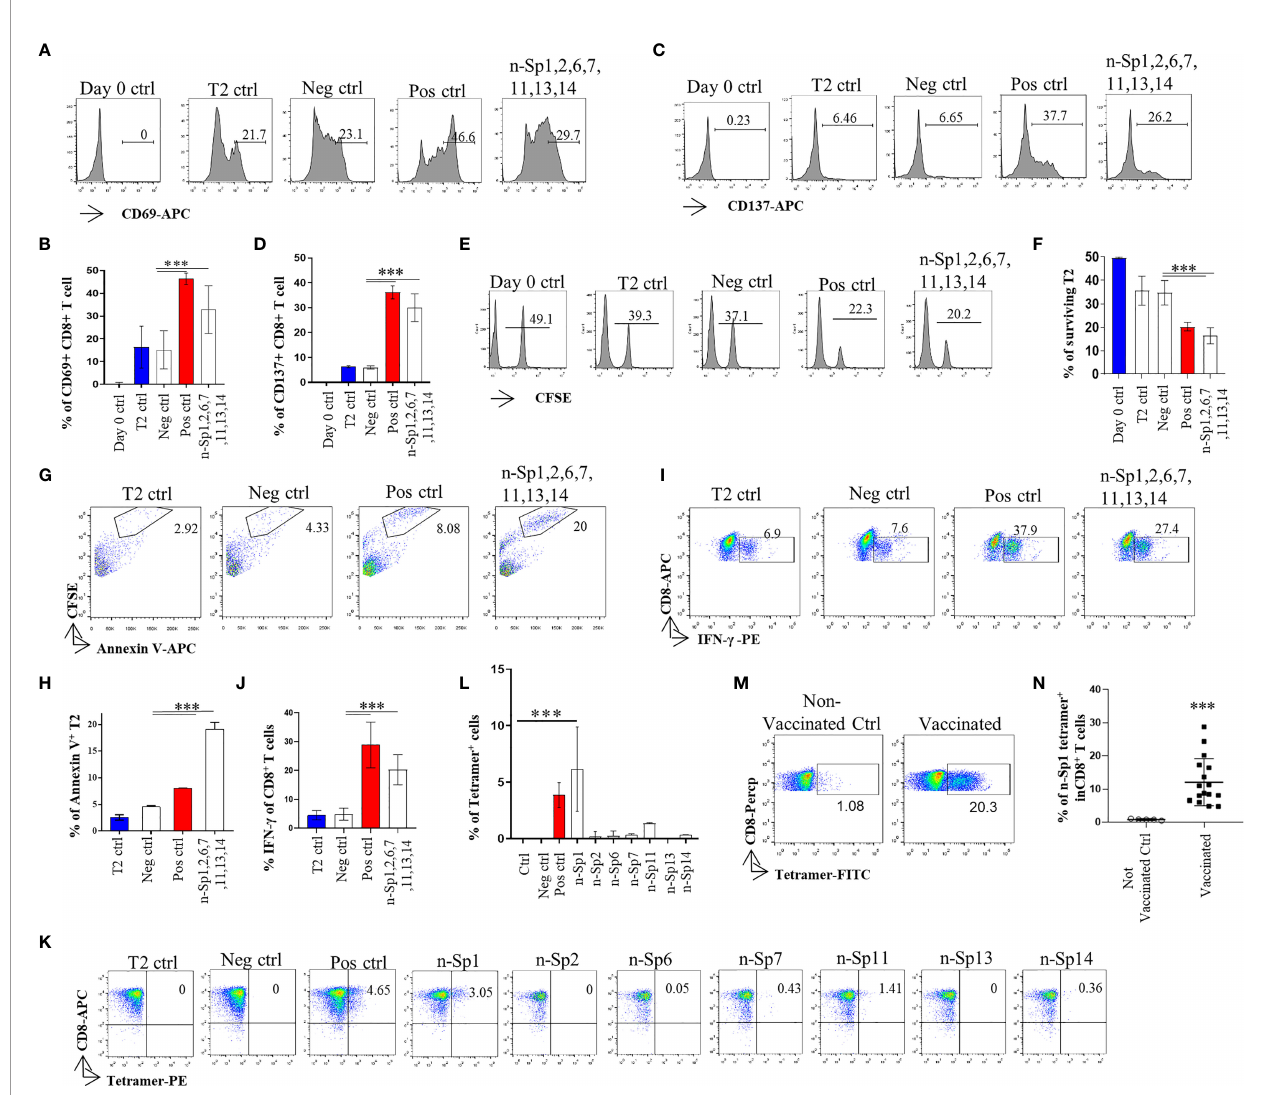
FIGURE 2 | Activation of CD8 + T cell by peptides on SARS-CoV-2 Spike protein. (A, B) Mitomycin pretreated T2 cells were loaded with n-Sp1, 2, 6, 7, 11, 13, and 14 peptides and incubated with CD8 + T cell from healthy donors at a 1:1 ratio. Activation, cytotoxicity, and generation of epitope-speci fi c CD8 + T cells were evaluated. Expression level of the T-cell activation marker CD69 was evaluated with fl ow cytometry after 16 h of stimulation. (B) Values indicate the percentage of CD69 + CD8 + T cells, n = 3. (C, D) Expression level of the T-cell activation marker CD137 was evaluated with fl ow cytometry after 16 h stimulation. (D) Values indicate the percentage of CD137 + CD8 + T cells. n = 3. (E, F) Epitope-speci fi c CD8 + T-cell-mediated cytotoxicity was evaluated after 7 days of culture. The remaining CFSE- labeled T2 cells were calculated as survived target cells. (F) Values indicate the percentage of surviving T2 cells, n = 3. Apoptosis of T2 cells after 7 days culture.